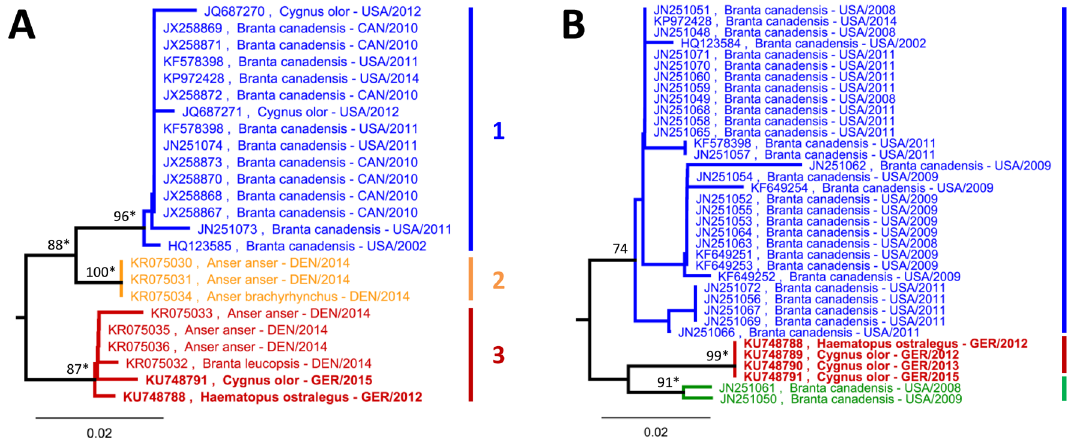
Fig 2. ABBV-1 sequences from wild aquatic birds form continent-associated clusters. Partial sequences of N (A, 320 bp) or M (B, 200 bp) genes of ABBV-1 were analysed. Phylogenetic analysis was performed using Neighbor-Joining algorithm and Jukes-Cantor distance model in Geneious R8. The trees were rooted with Bornaviridae references sequences (not shown; see Fig 1). Values at branches represent support in 1,000 bootstrap replicates. Only bootstrap values (cid:1) 70 at major branches are shown. Nodes with bootstrap support of (cid:1) 90 in additionally performed ML analysis are indicated by asterisks. Sequences depicted in bold were generated during this study. Clusters 3 and 4 were confirmed to be independent by alignment of short overlapping partial M gene sequences (113 bp) from both clusters (data not